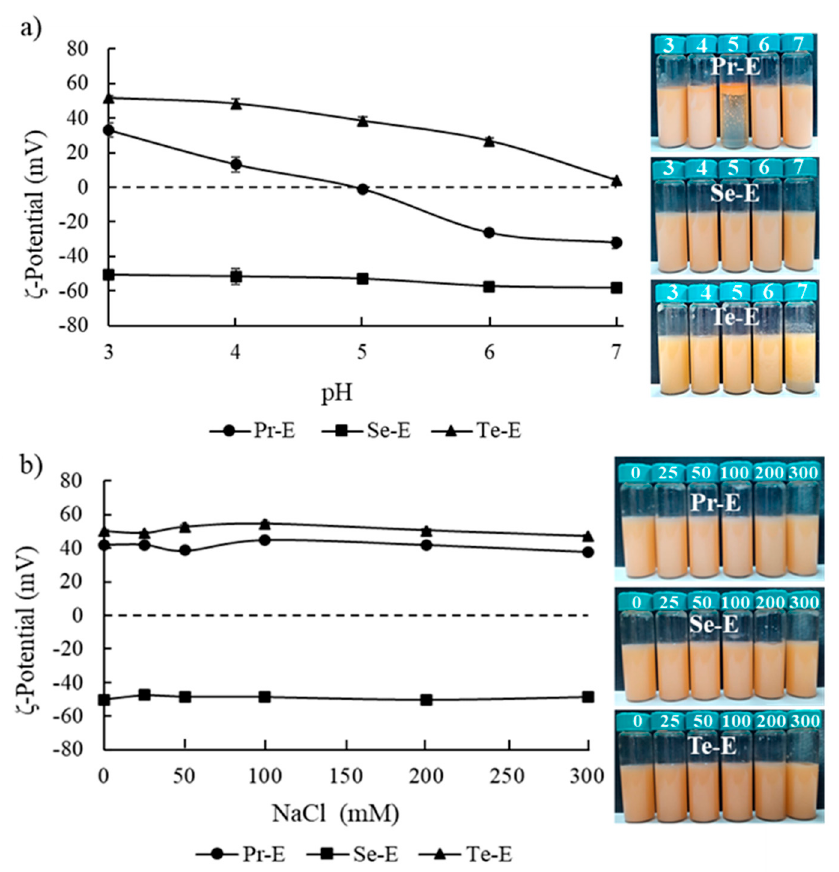
Figure 6. Effect of the ( a ) pH (3 – 7) and ( b ) NaCl (0 – 300 mM NaCl) on ζ -potential of emulsions.